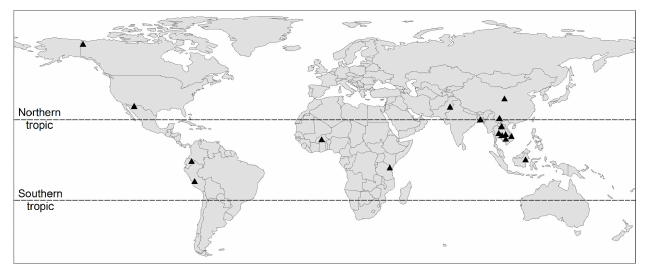
Fig. 2 . Global distribution of model